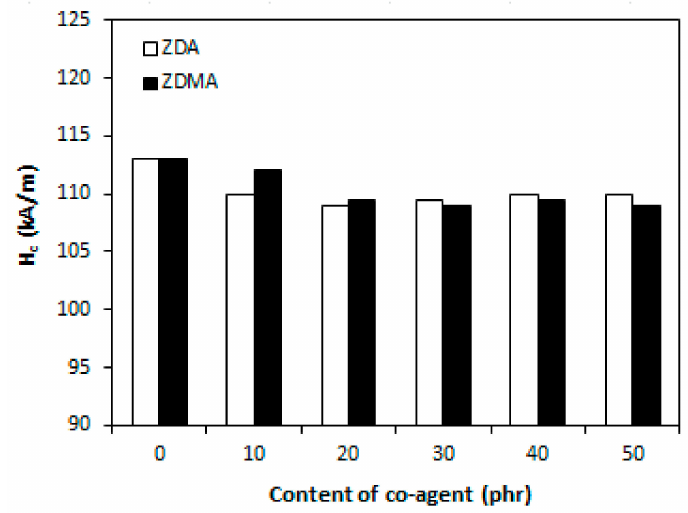
Figure 10. Influence of co-agents content on coercivity H c of composites.